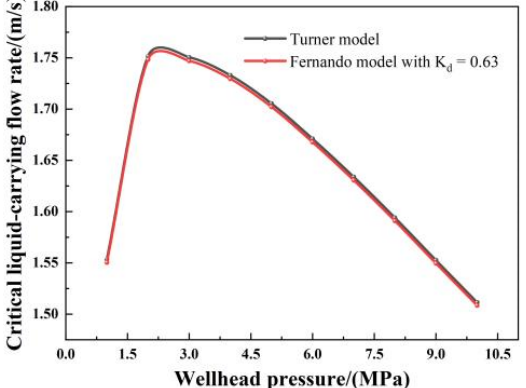
Figure 2. Drag coefficient for the inclined section determined using the Turner and Fernando models.